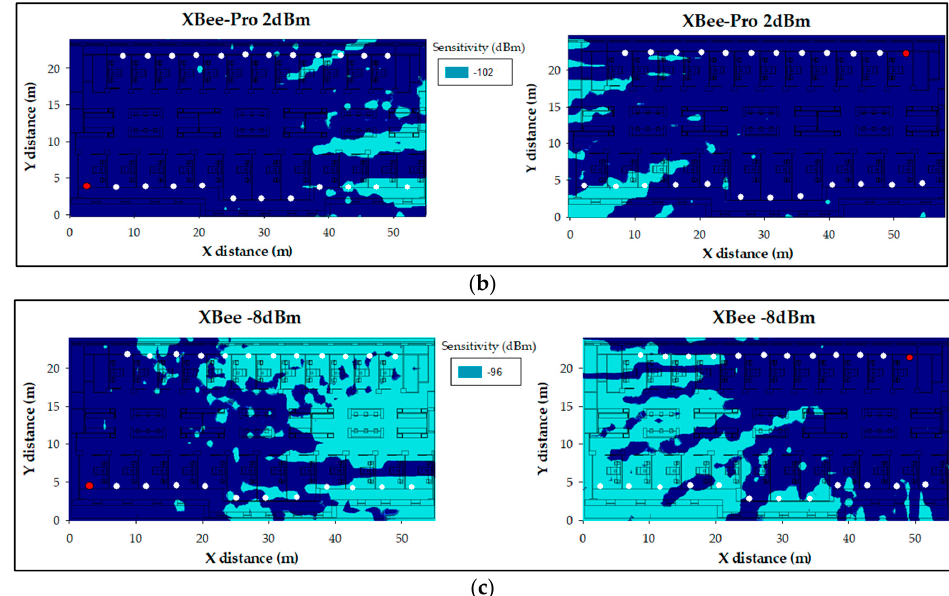
Figure 16. Sensitivity fulfillment planes corresponding to: ( a ) XBee-Pro motes transmitting 10 dBm; ( b ) XBee-Pro motes transmitting 2 dBm; and ( c ) XBee motes transmitting − 8 dBm. Red dots represent the transmitter mote position.